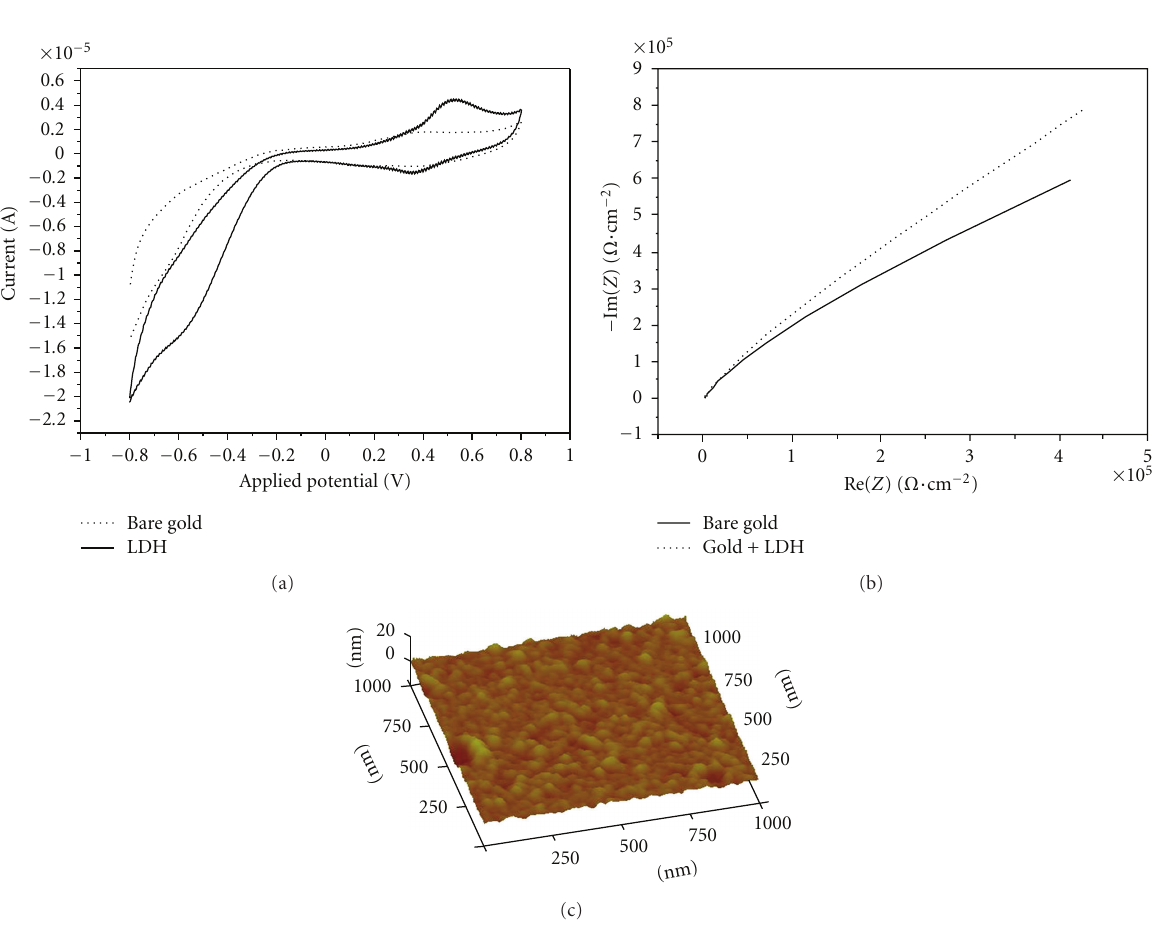
Figure 1: (a) Cyclic voltammetry measurement in PBS bu ff er of bare gold electrode and gold electrode with LDH, respectively. (b) Nyquist diagram ( Z i versus Z r ) of impedance measurement corresponding to the gold electrode without and with LDH layer. (c) Atomic force microscopy photo of gold surface treated with LDH. It shows a homogenous surface with roughness below